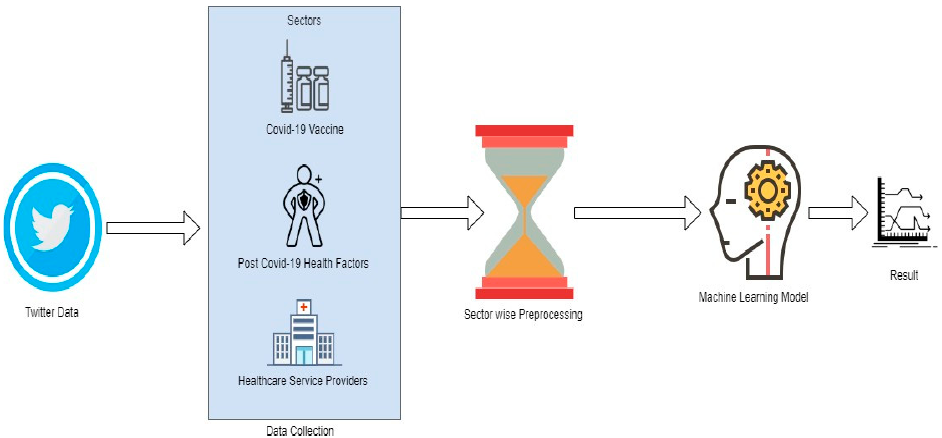
Figure 1. Processing structure.